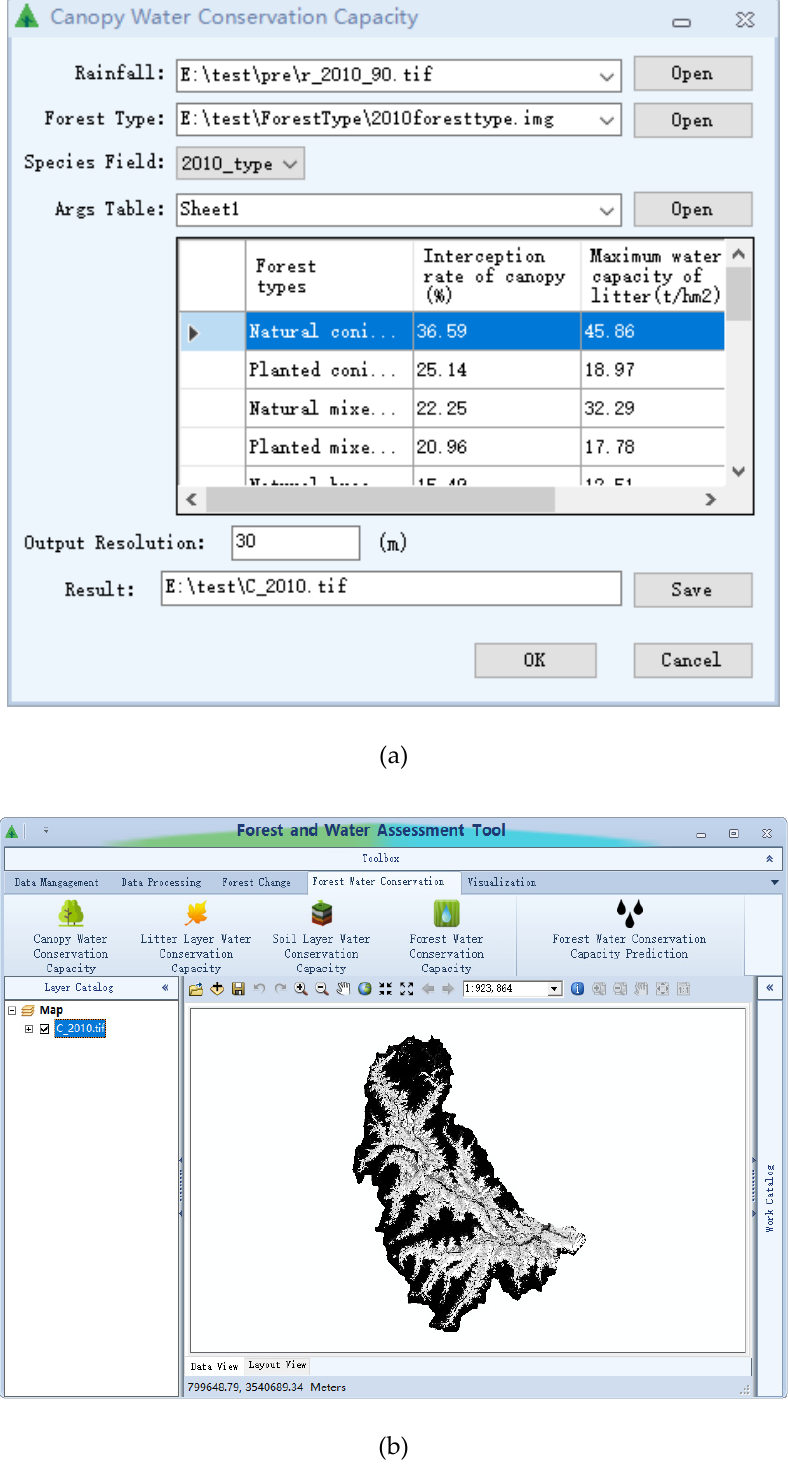
Figure A3. An example of canopy water conservation capacity calculation by use of the FWAT. ( a ) Parameters input; and ( b ) the result displayed in FWAT.